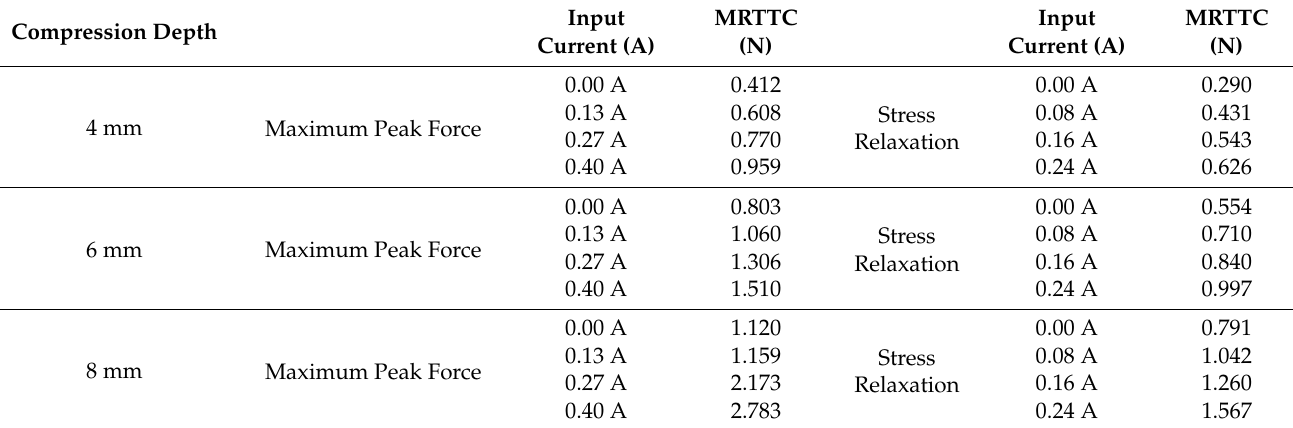
Table 3. Peak force and relaxation force values for each compression